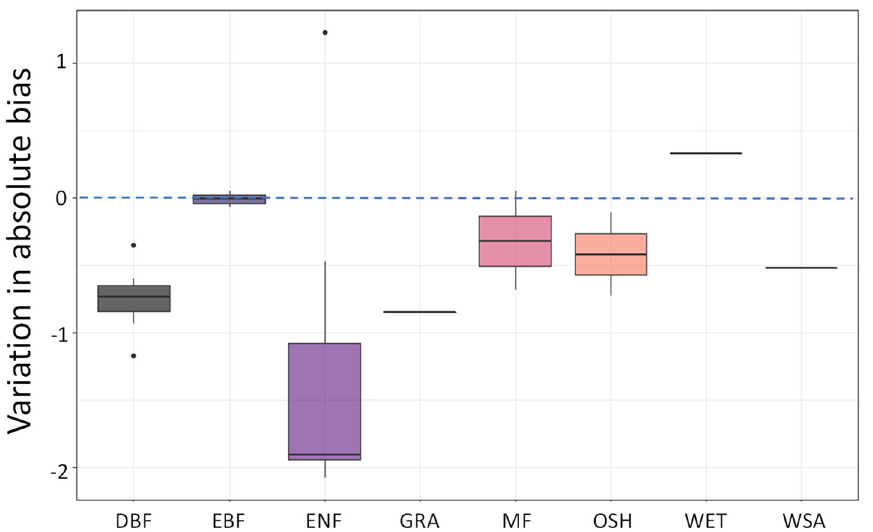
Figure 4. Variation in absolute bias between the ground-measured GPP and the satellite-estimated GPP after adding biome CI information to the NIR and PPFD model (GPPnirppfdci vs. GPPnirppfd) for the different vegetation cover types.